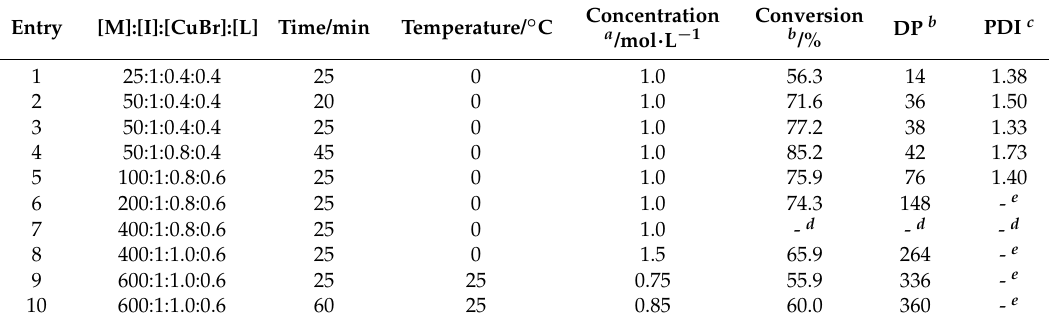
Table 1. Experimental data of Cu 0 -mediated LRP of